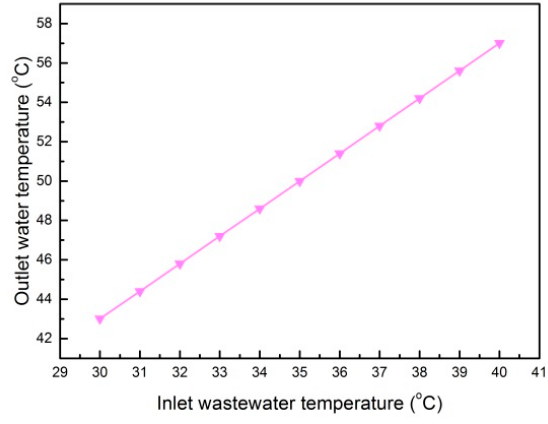
Figure 3. Influence of inlet wastewater temperature on outlet water temperature.